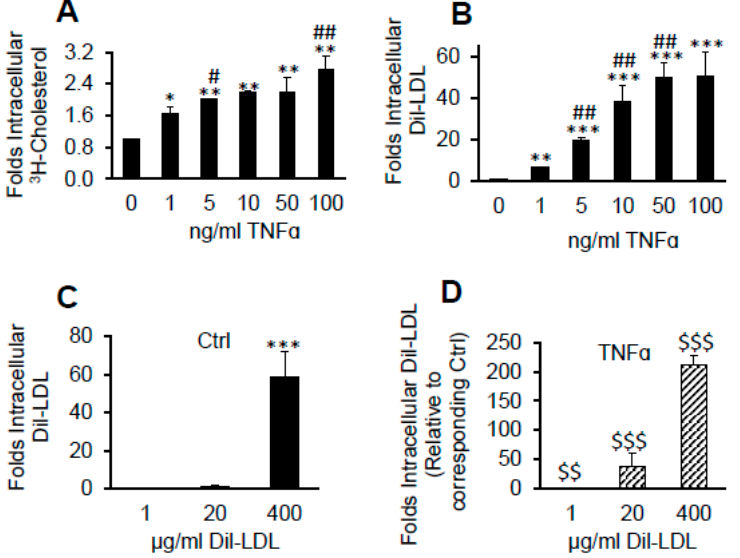
Figure 4. TNF α induces massive Dil over [ 3 H]CE lipid accumulation from LDL. pHAECs in serum medium were pre-treated with the indicated concentration of human TNF α for 24 h. Subsequently, the cells were treated in the continued presence of the previous TNF α concentration and 50 µ g/mL [ 3 H]CE-LDL ( A ) or 5 µ g/mL Dil-LDL ( B ) without serum for 24 h. A, n = 4, B, n = 3. The cells were treated without (Ctrl), ( C ), or with 100 ng/mL TNF α ( D ), as above, in the presence of increasing concentration of Dil-LDL. n = 5. *, **, ***, p < 0.05, 0.01, 0.001, relative to 0 ng/mL TNF α or 1 µ g/mL Dil-LDL. #, ##, p < 0.05, 0.01, vs. previous TNF α dose. $$, $$$, p < 0.01, 0.001, relative to the corresponding Dil-LDL concentration under Ctrl